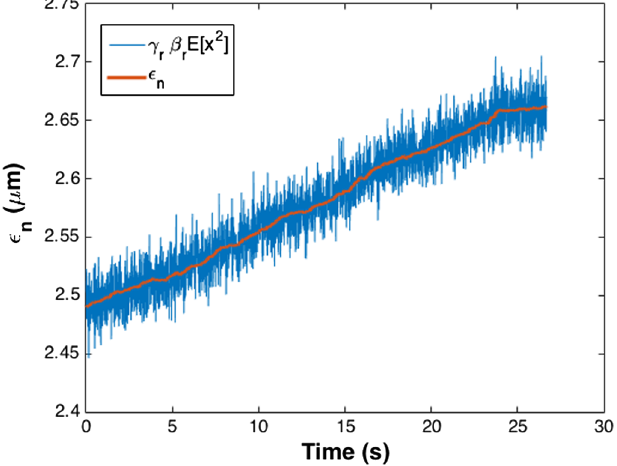
β E ½ x 2 (cid:3) from simulation. r r